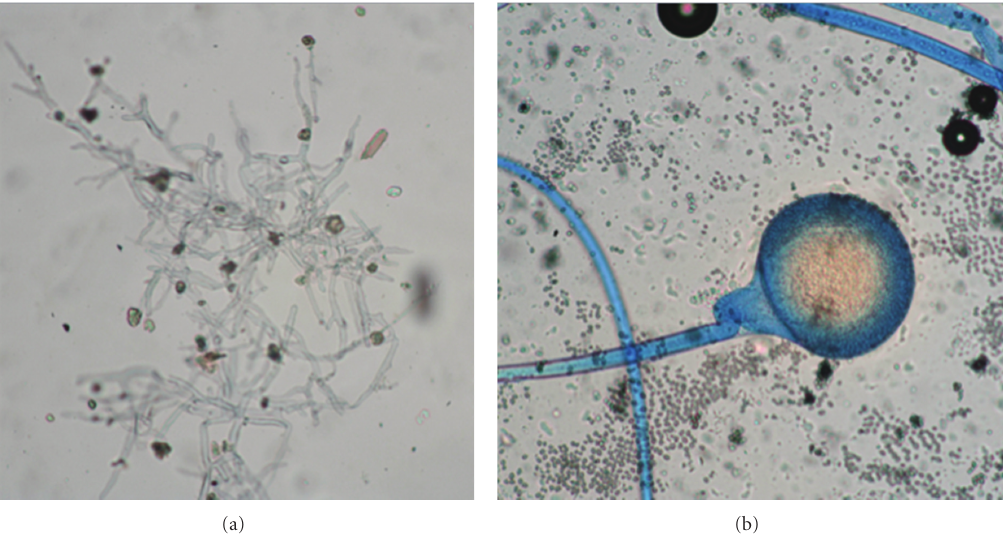
Figure 5: (a) KOH exam showing nonseptate hyphae branched at 90 ◦ degrees. (b) Sporangiophores with sporangia and underdeveloped stolones, compatible with Rhizomucor sp